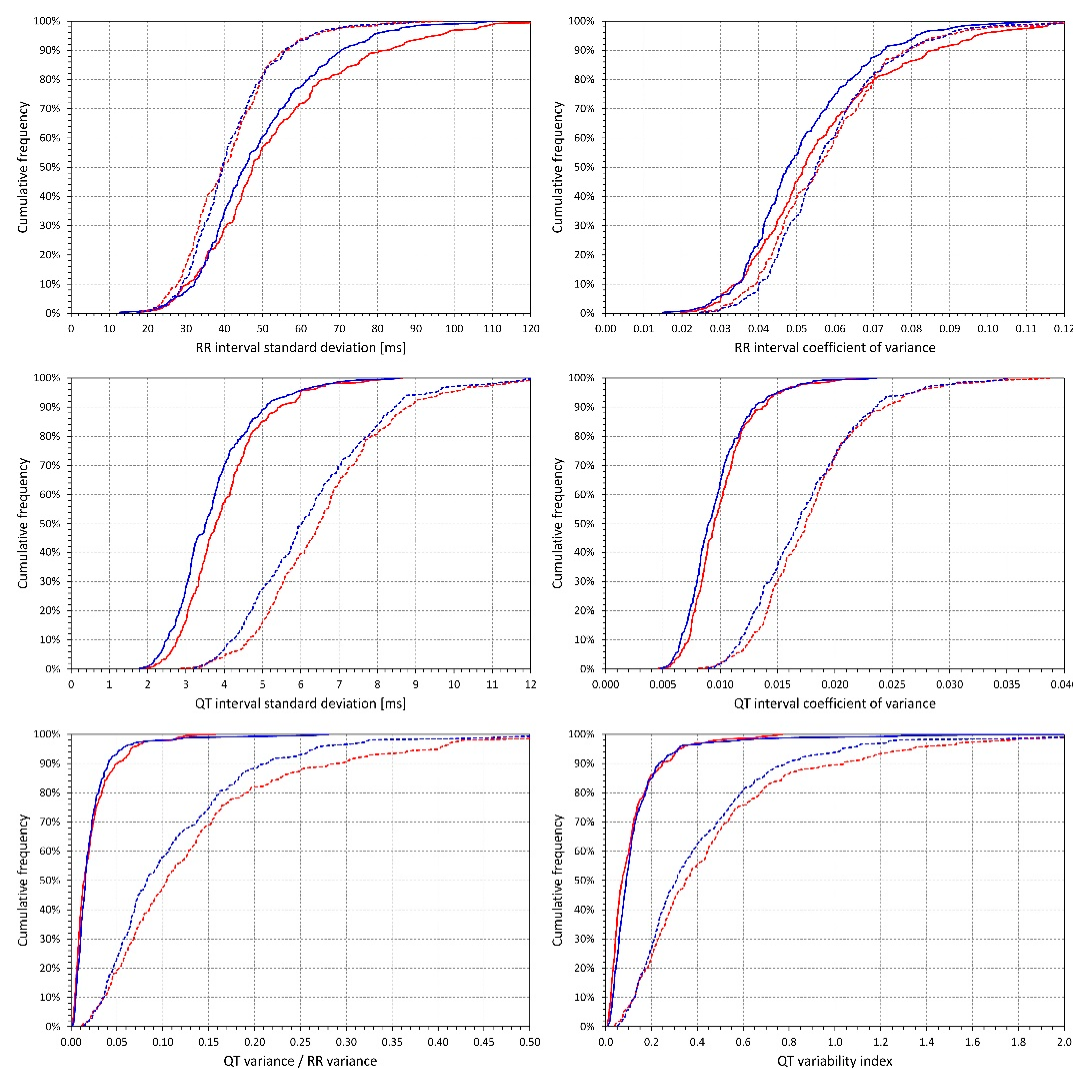
Figure 1. Values of measured indices. For each of the investigated indices (see the labels of the horizontal axes of individual panels) the figure shows the cumulative distributions of intra-subject means calculated over electrocardiograms (ECGs) with heart rate between 50 and 75 bpm (full lines) and between 75 and 100 bpm (dashed lines). The red and blue lines correspond to female and male subjects,